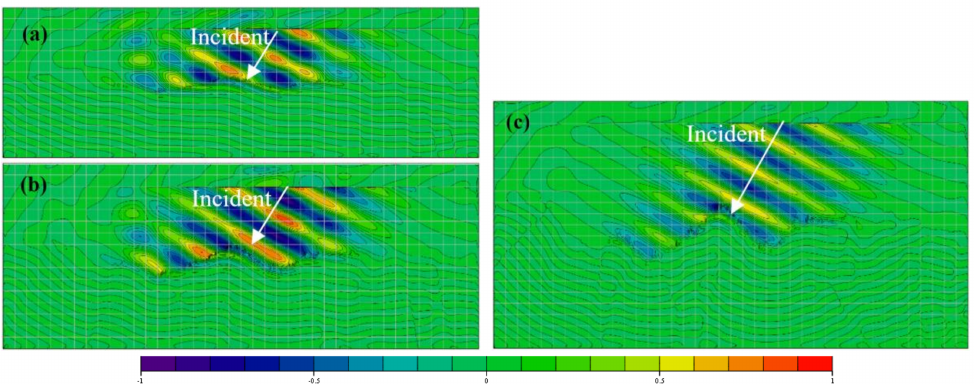
Figure 14. Recorded total field (E-Field, maximum normalized, real part) in the incident plane cut from the exponentially correlated rough surface simulation, θ i = 30 ◦ . ( a ) h = 2 mm, ( b ) h = 4 mm, ( c ) h = 8 mm.